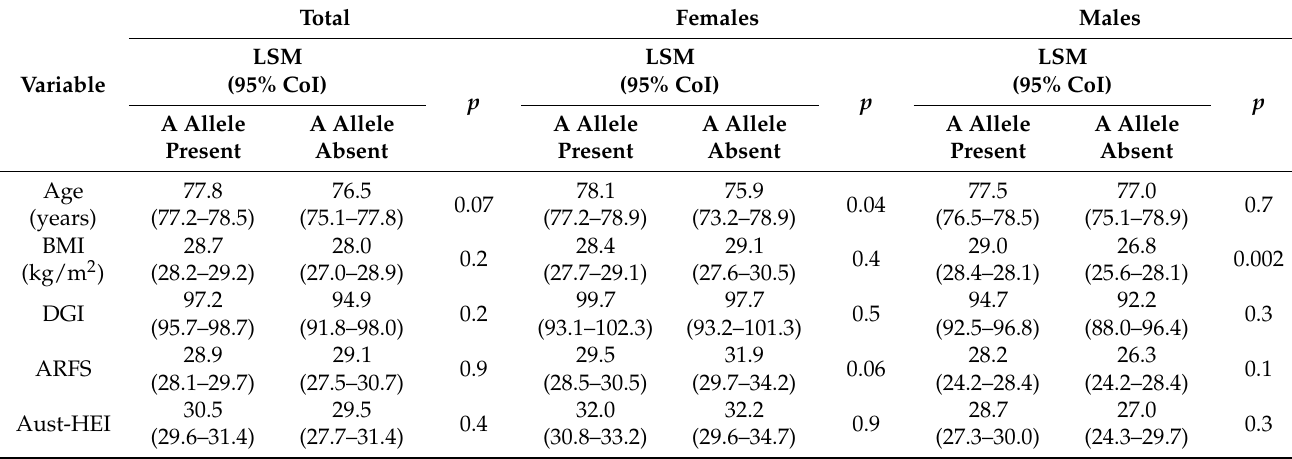
Table 5. Demographic and clinical characteristics by presence of the KCNJ2 -rs236514 variant (A) allele in the total cohort and by sex (continuous